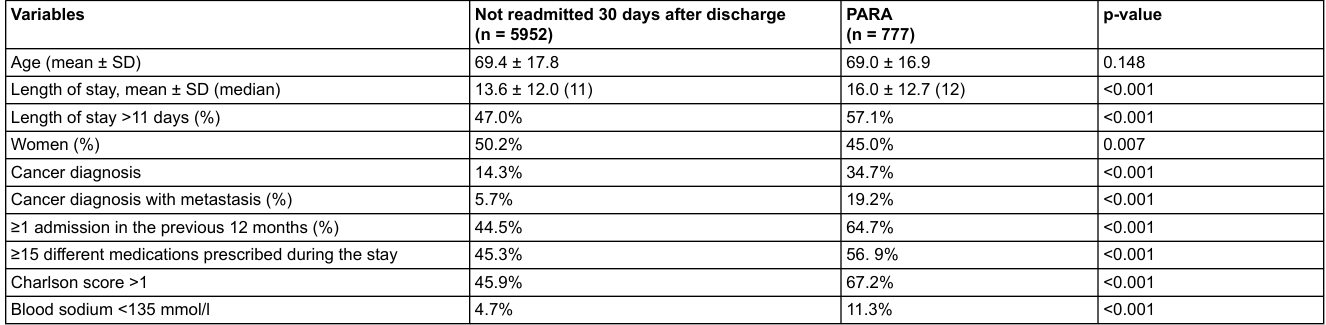
Table 2: Patient characteristics that distinguish stays followed by a PARA (n = 777) from those not followed by readmission (n = 5952) among eligible hospital stays (n = 6729). Variables